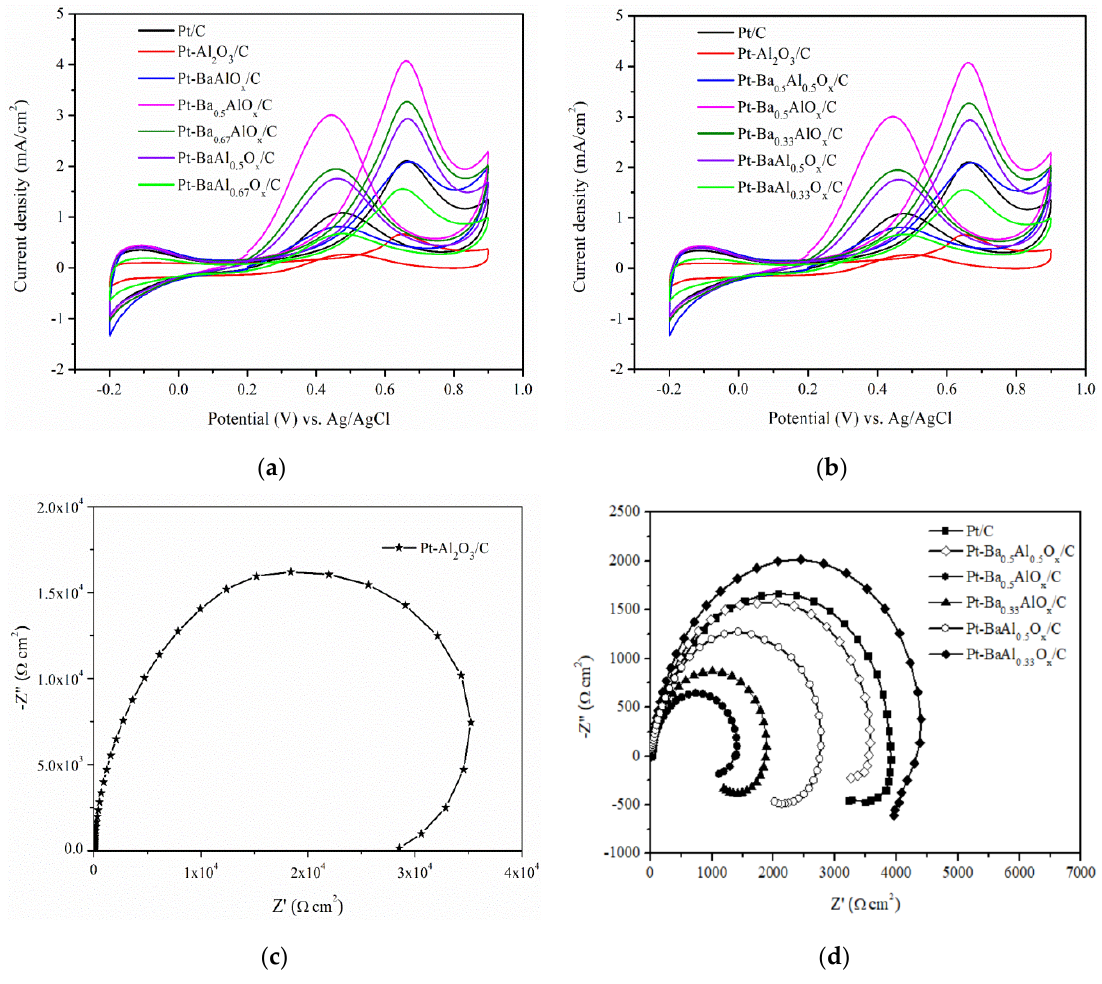
Figure 5. ( a ) CV curves in 1 M CH 3 OH + 0.5 M H 2 SO 4 and ( b ) in 0.5 M H 2 SO 4 . Nyquist plots of ( c ) 20%Pt-Al 2 O 3 / C catalysts and ( d ) various catalysts. Table 1. Maximum current density, potential, and electrochemically active surface area (ECSA) of different catalysts in methanol electrooxidation reaction (MOR).